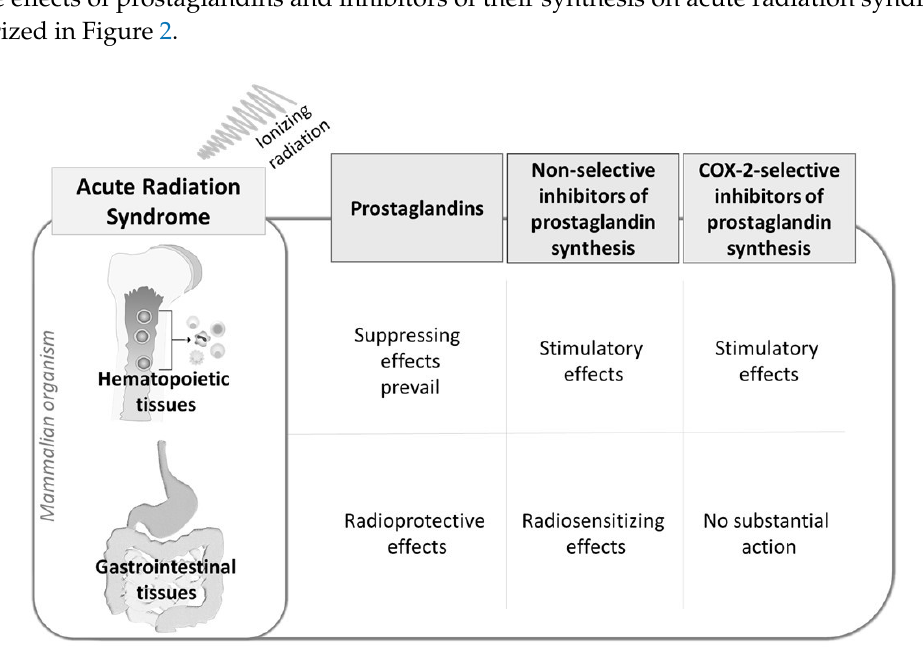
Figure 2. Summarization of the effects of prostaglandins and inhibitors of their synthesis in acute radiation syndrome. radiation